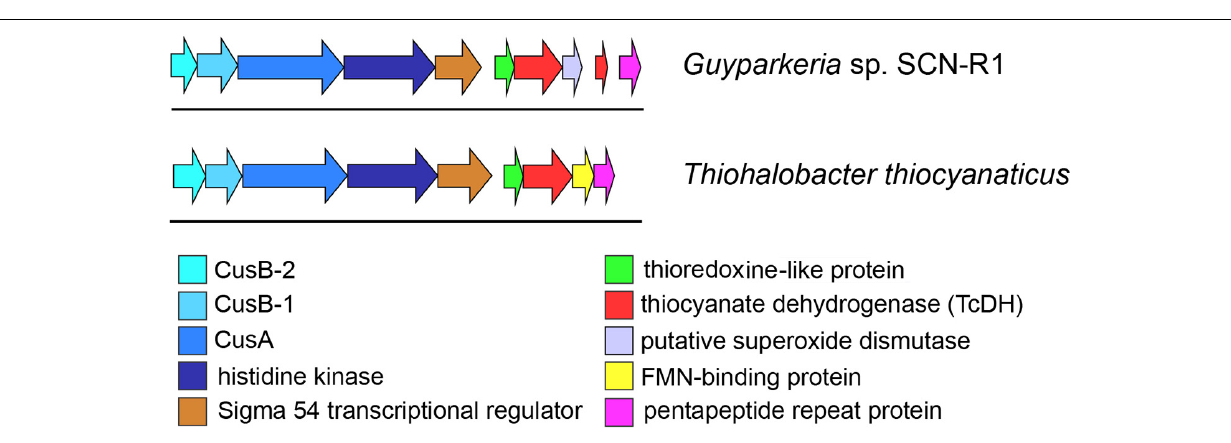
FIGURE 5 | Genome region around TcDH gene in Thiohalobacter thiocyanaticus and Guyparkeria SCN-R1. Both organisms contain a number of similar genes around TcDH in the same order (colored arrows). “Blue” genes are likely to be related to a copper transport system